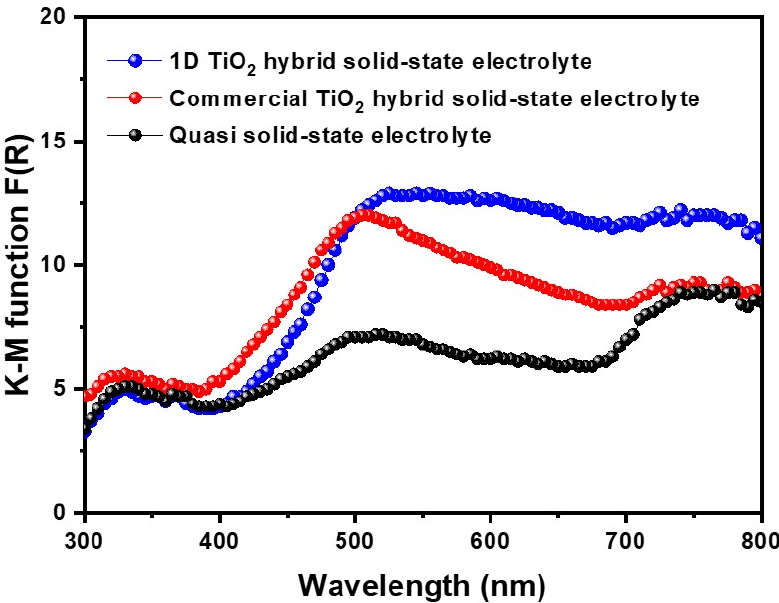
Figure 5. Kubelka-Munk (KM) function of quasi solid-state electrolyte, commercial TiO 2 hybrid solid-state electrolyte, and 1D TiO 2 hybrid solid-state electrolyte.